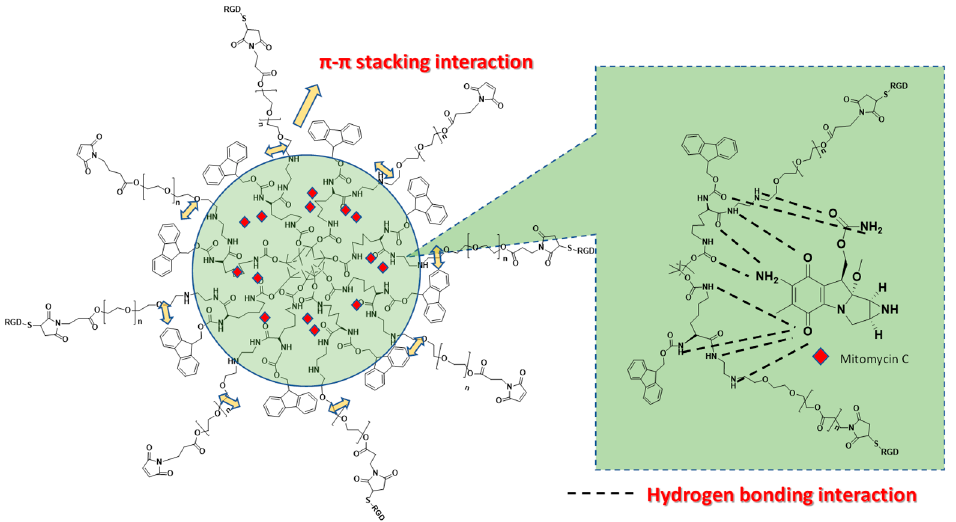
Scheme 1. Schematic diagram of MMC-loaded micellar assembly driven by the combined effect of hydrogen bonding and π – π stacking.